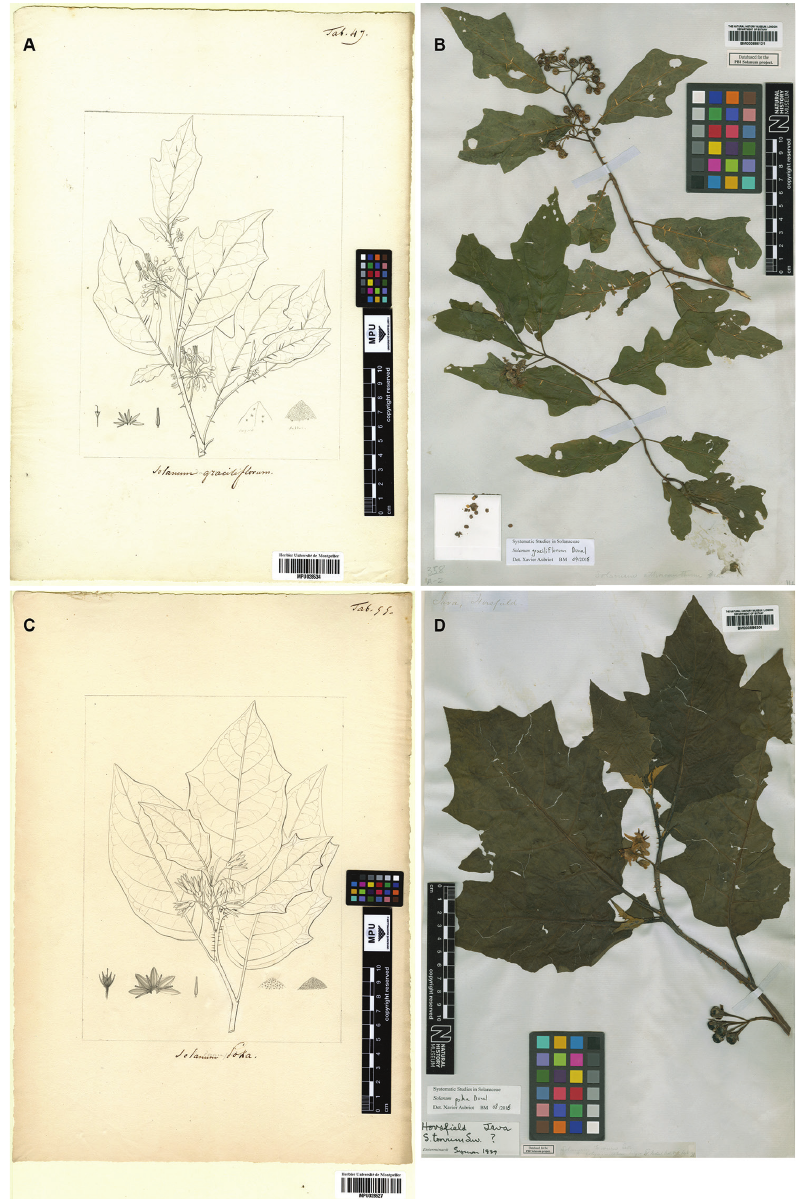
Figure 1. A Lectotype of Solanum graciliflorum , illustration Sol. Tab. 47 [MPU028534] made by T.F. Node-Véran (1773–1852). Reproduced with permission of the Université de Montpellier – Herbier MPU (Service de Patrimoine Historique); copyright Université de Montpellier – Herbier MPU (SPH) B Epi- type of Solanum graciliflorum , T. Horsfield s.n. [BM000886121] C Lectotype of Solanum poka , illustration Sol. Tab. 55 [MPU028527] made by T.F. Node-Véran (1773-1852). Reproduced with permission